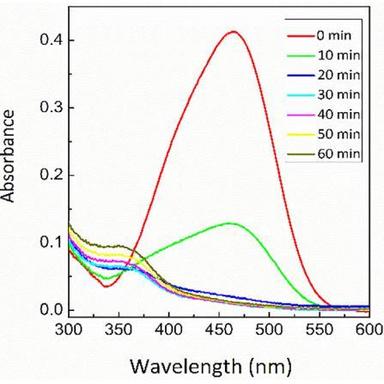
(a) UV–visible spectra of MO dye degradation, recorded at different time intervals.